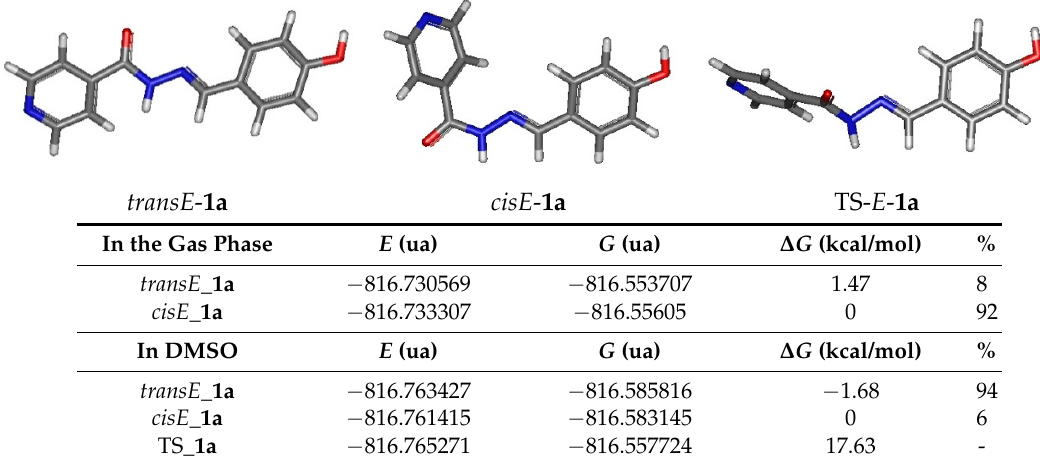
Table 2. Geometries and energies of minima and transition state for cis and trans E -isomers of 1a obtained at B3LYP/6-31+G(d,p) level in the gas phase and using the DMSO polarizable continuum model (SMD).